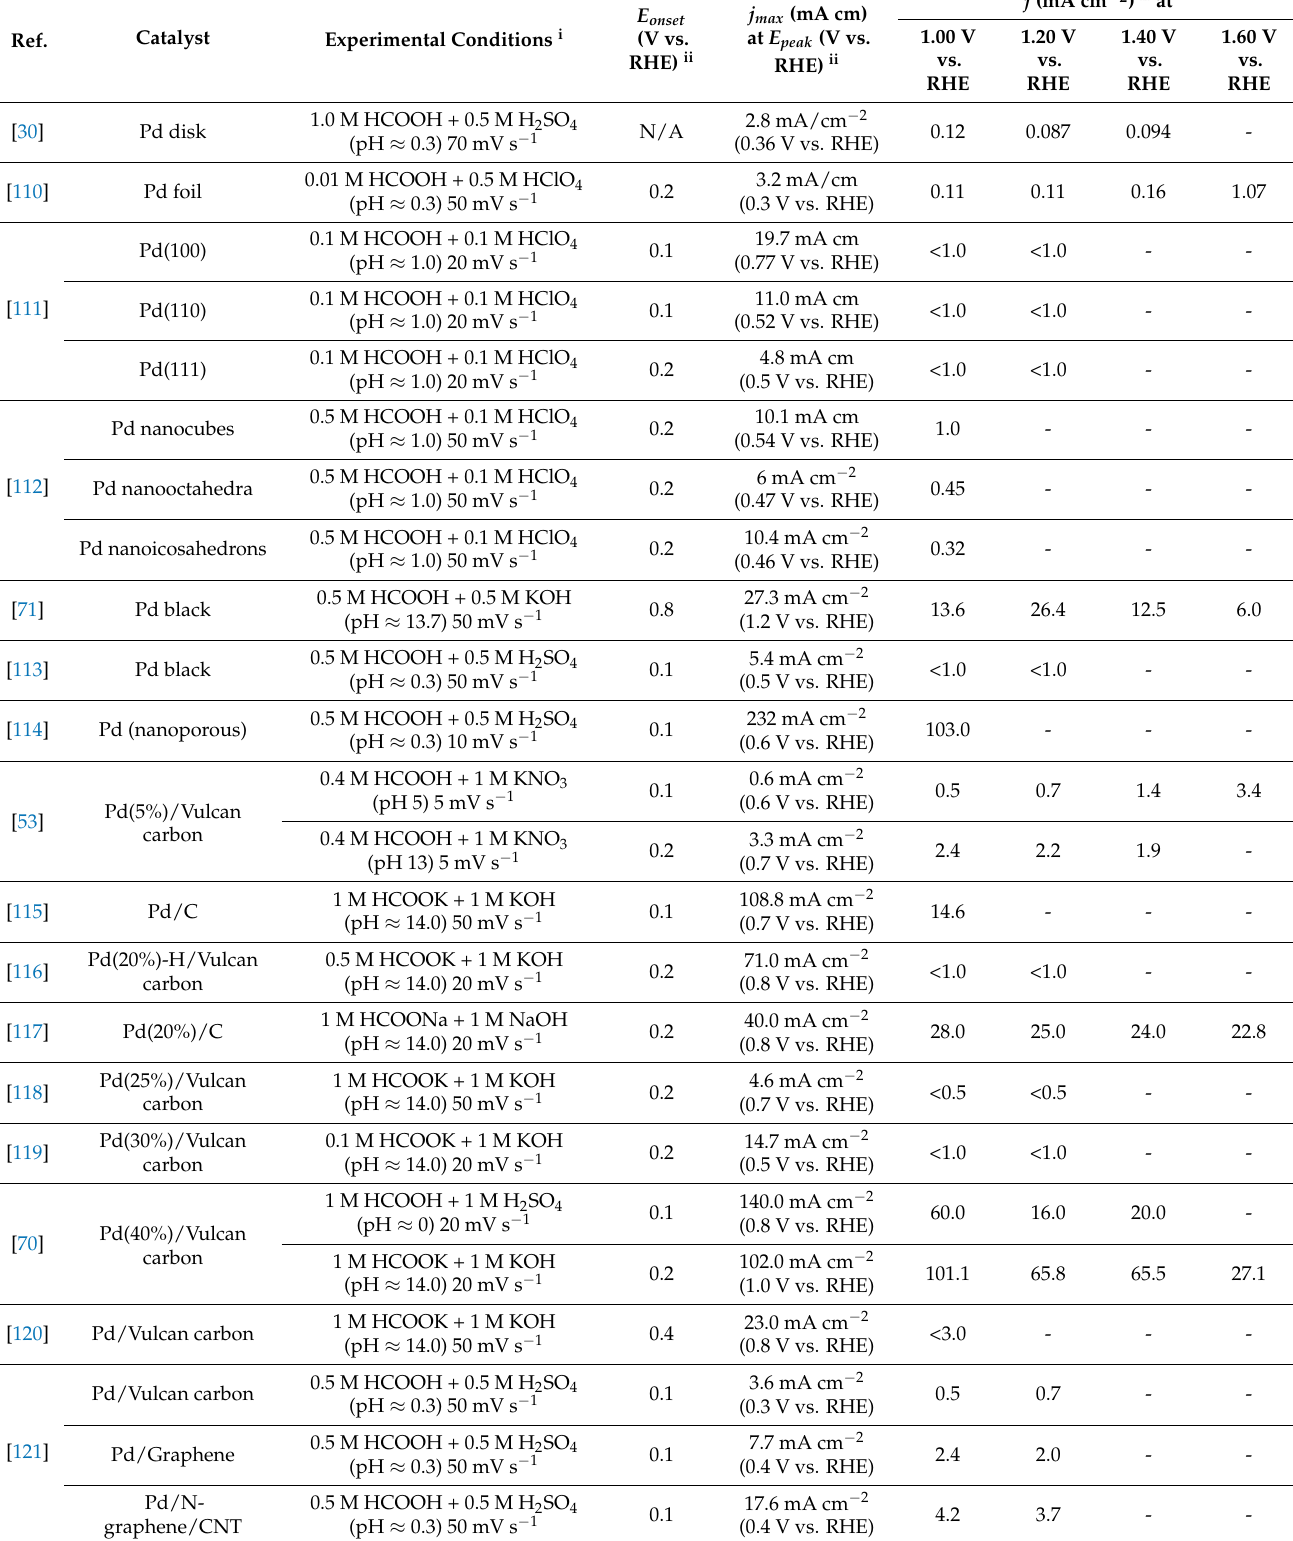
Table 3. Benchmarking of Pd-based electrocatalysts for formic acid/formate oxidation in half-cell configuration at ambient conditions, in acidic and basic media, in terms of onset potential ( E onset ), maximum current density ( j max , normalized by electrode geometric area) obtained on anodic peaks (at a potential E peak ) and current density ( j ) obtained at given potentials.